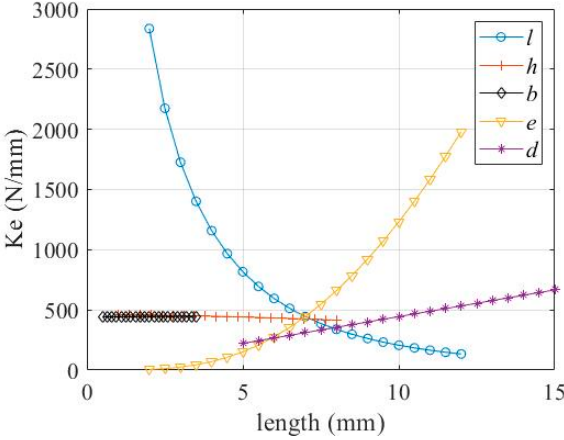
Figure 10. Relationship between K e and h , l , e , b , d.